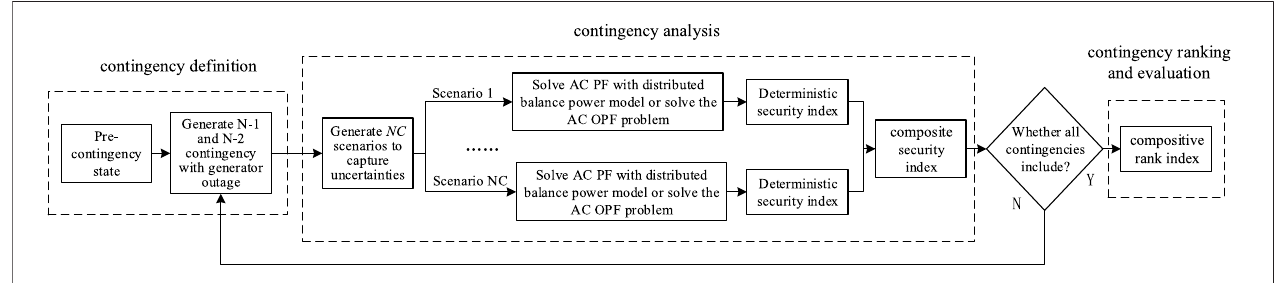
FIGURE 1 | The process of traditional stochastic